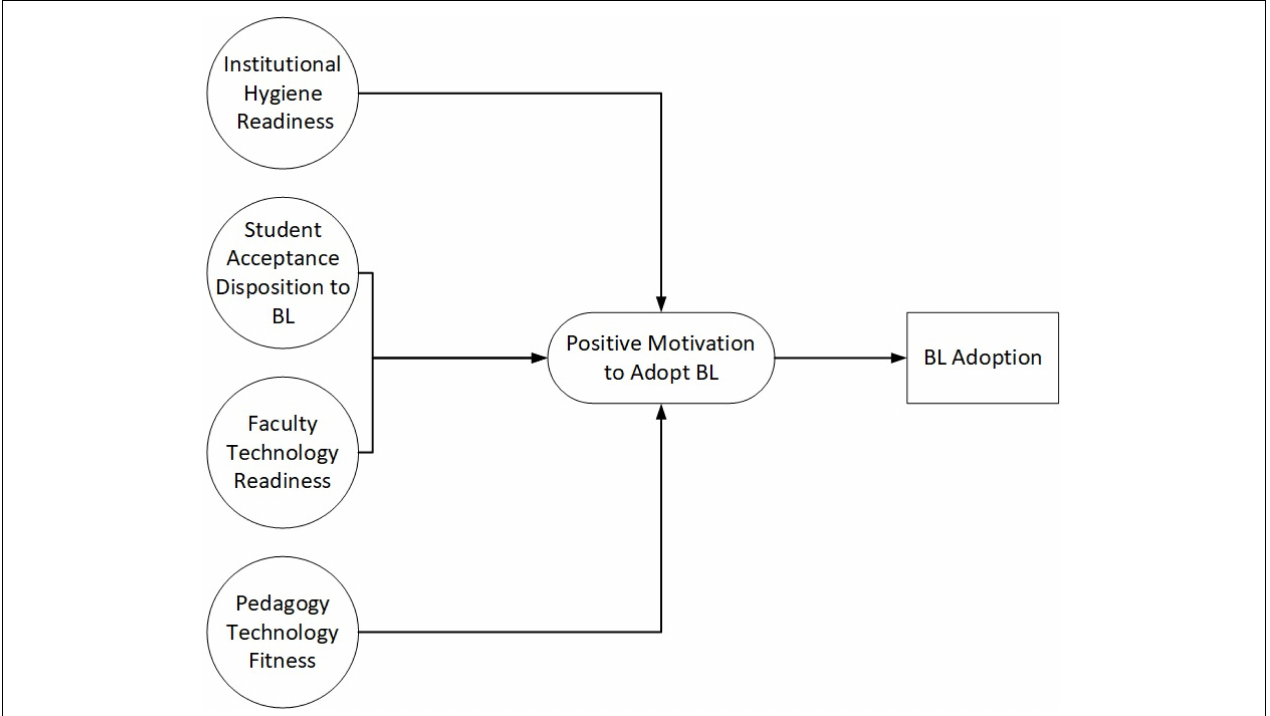
FIGURE 1 | Faculty blended learning adoption model [adopted from Antwi-Boampong (2020)].